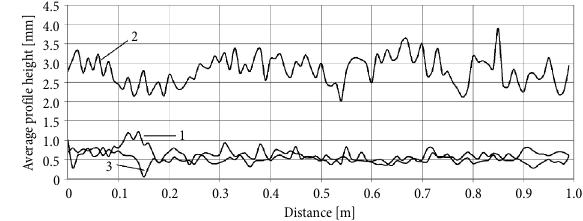
Fig. 3. Average height values of the asphalt pavement: 1, 2, 3 – road stretches